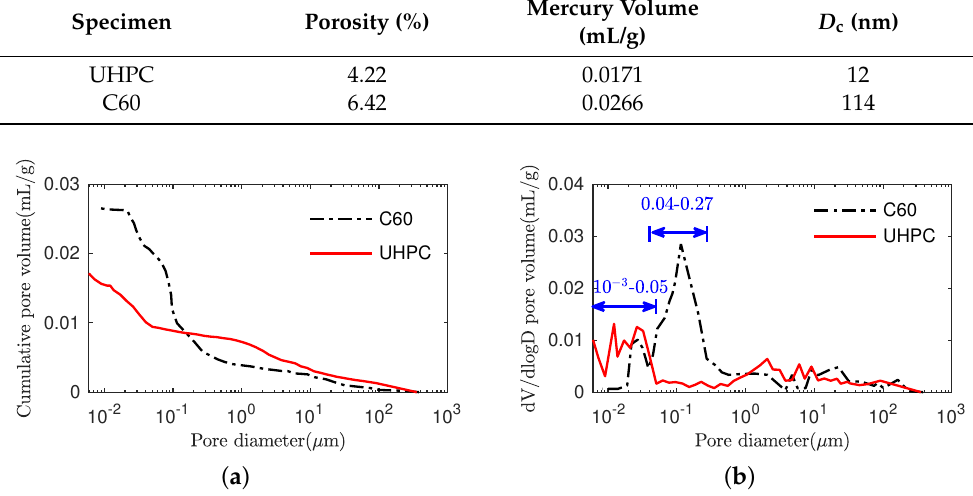
Figure 11. Distributions of the pore volume: ( a ) Cumulative pore volume curves; ( b ) Log differential pore volume